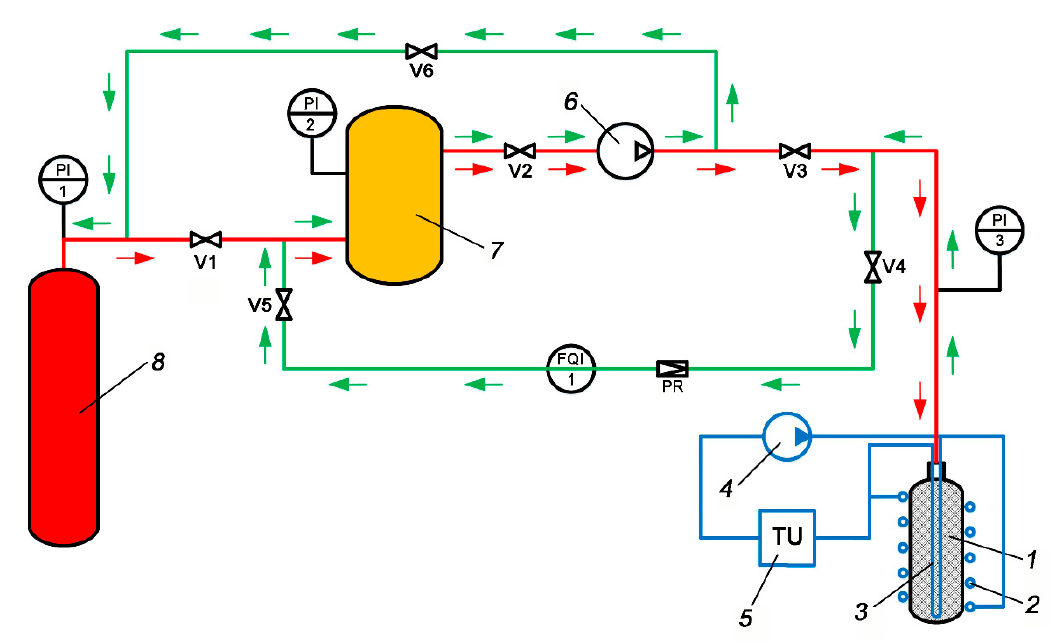
Figure 1. Scheme of the test bench for investigation of the thermal effects of the methane charge/discharge processes of the adsorbed natural gas (ANG) system. 1—storage tank (adsorber) filled with a shaped activated carbon (AC), 2—external heat-exchanger, 3—internal heat-exchanger, 4—coolant circuiting pump, 5—thermostatic unit TU, 6—gas compressor, 7—low-pressure receiver, 8—high-pressure receiver, V1—V6—gas valves, PR—pressure regulator, PI1—3–gauges, FOI1—gas meter. The red arrows indicate the gas charge process; the green arrows correspond to the gas delivery process.